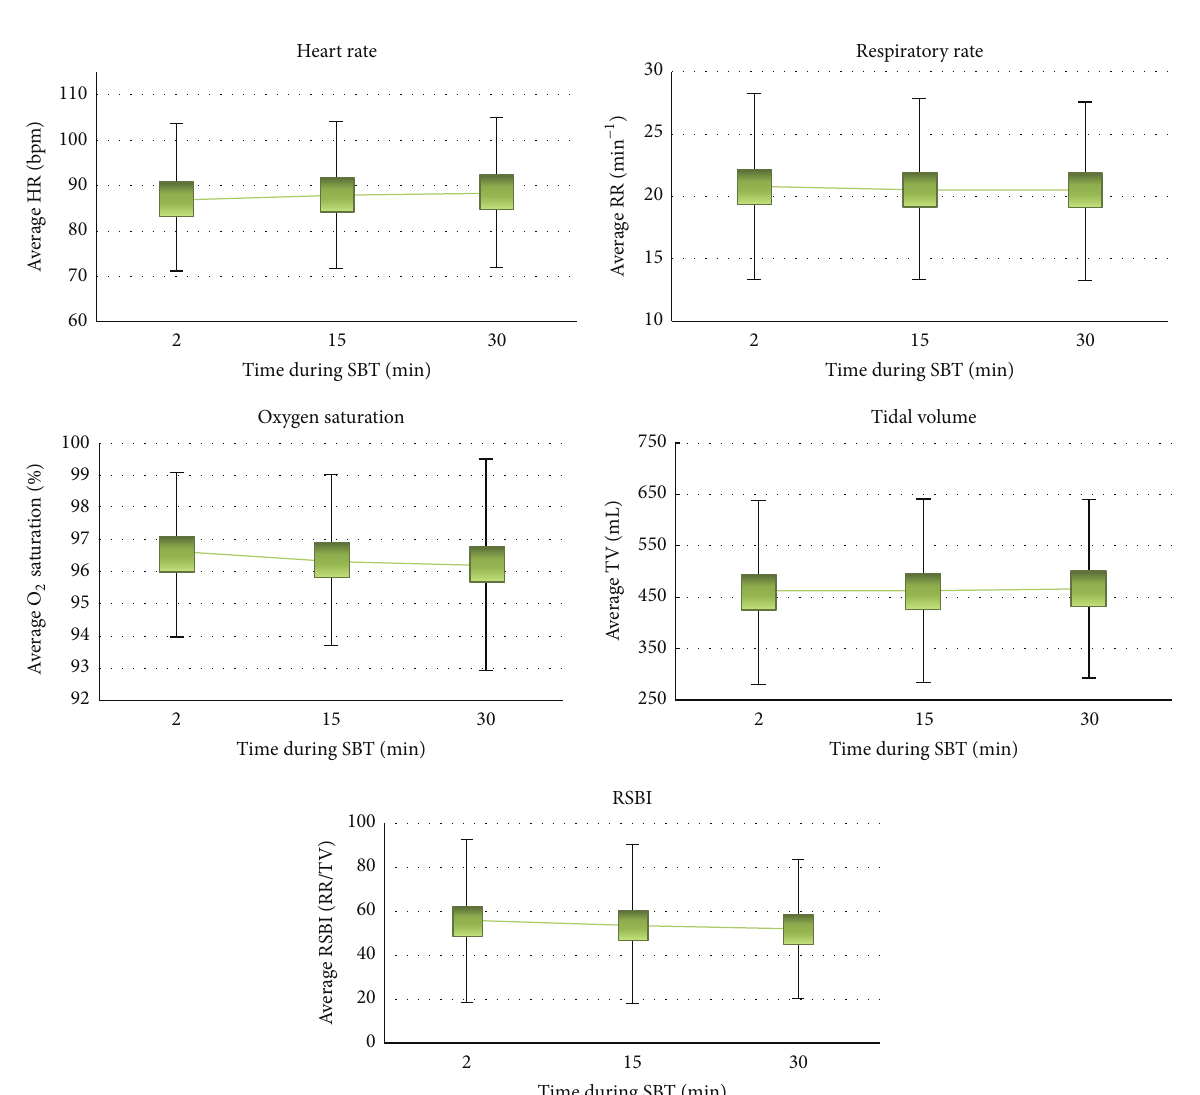
Figure 4: Average physiological variables (heart rate [HR], beats/min; respiratory rate [RR], breaths/min; tidal volume [TV], mL; O 2 saturation, %) and rapid shallow breathing index (RSBI), RR/TV. This series of figures depict the change in average physiological variable over three time points (2 min, 15min, and 30 min). Averages were calculated across all spontaneous breathing trials (SBTs) with available data at each time point. Error bars represent 1 standard